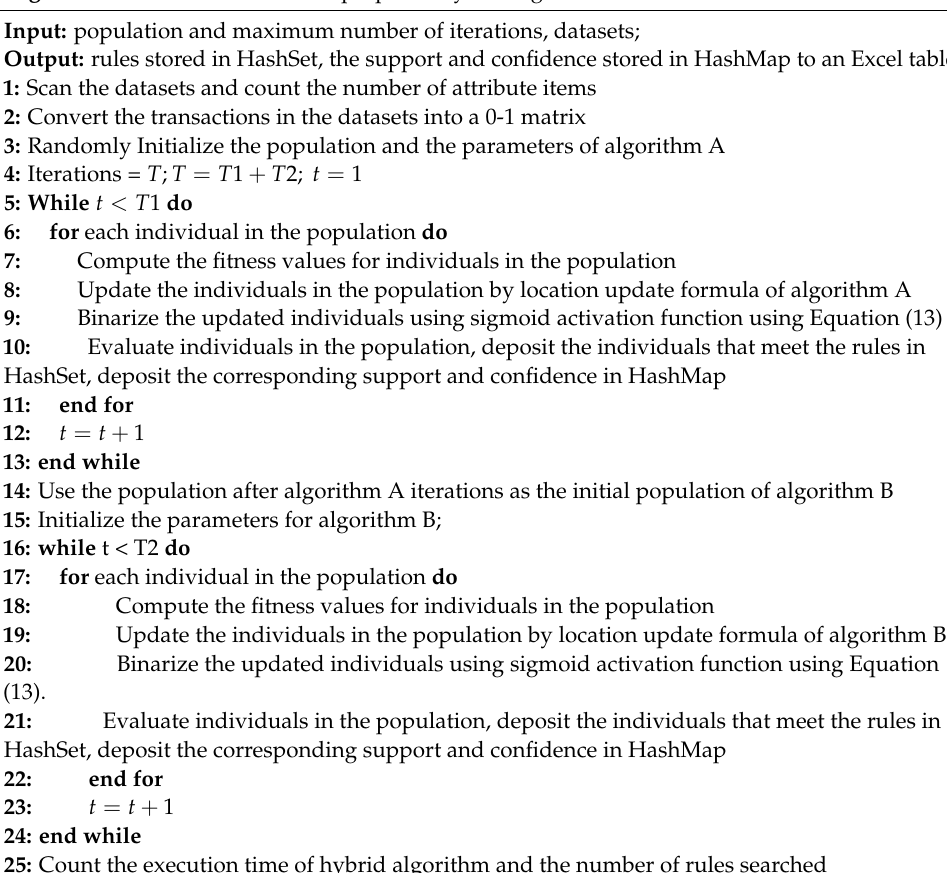
Algorithm 2: Pseudo-Code of the proposed hybrid algorithm based on